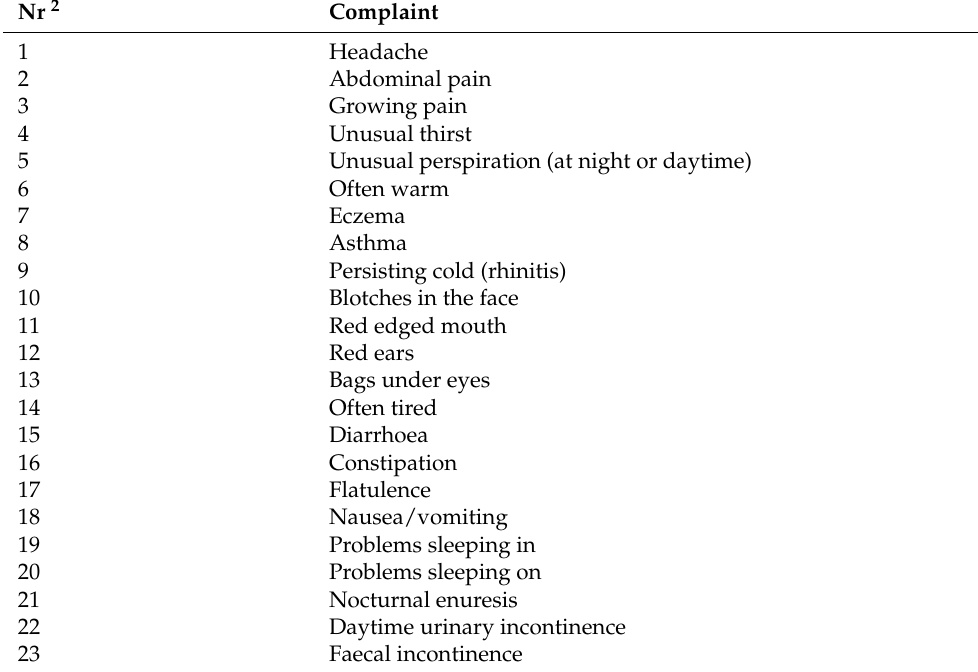
Table 1. Physical complaints included in the physical complaint questionnaire 1